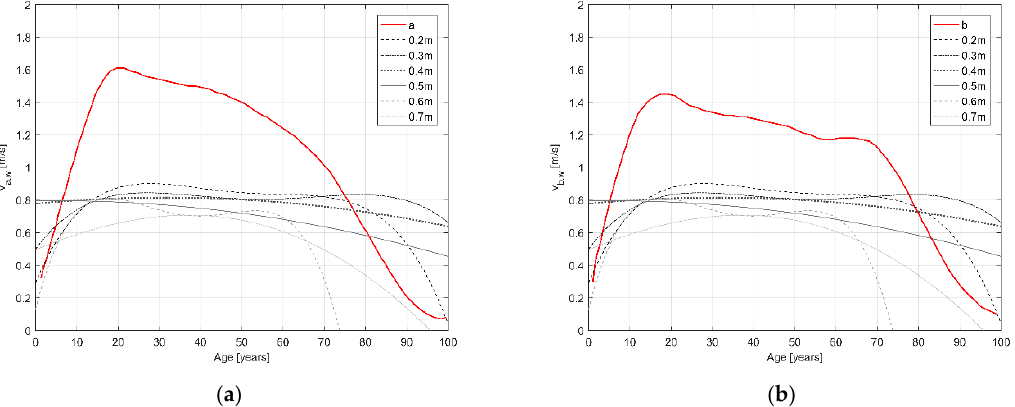
Figure 12. Average dimensional age-evacuation speed (m/s) model in walking conditions, for the different D values according to a polynomial (4th degree) regression model, performed on all the experimental pairs (male and female together): ( a ) compared to the curve a [46]; ( b ) compared to the curve b [43].